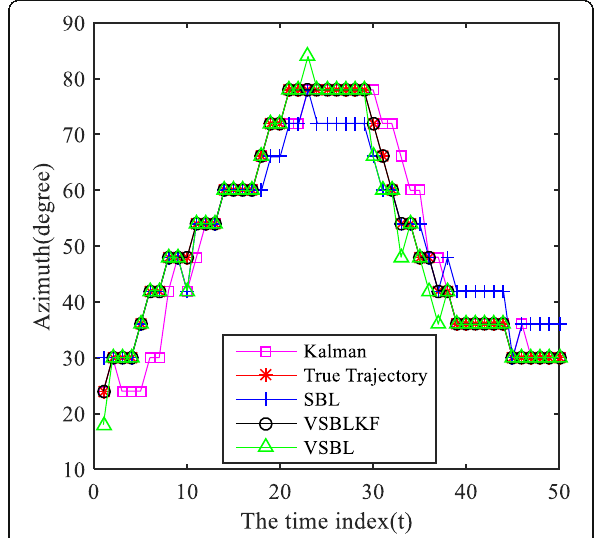
Fig. 5 Estimated azimuth as a function of